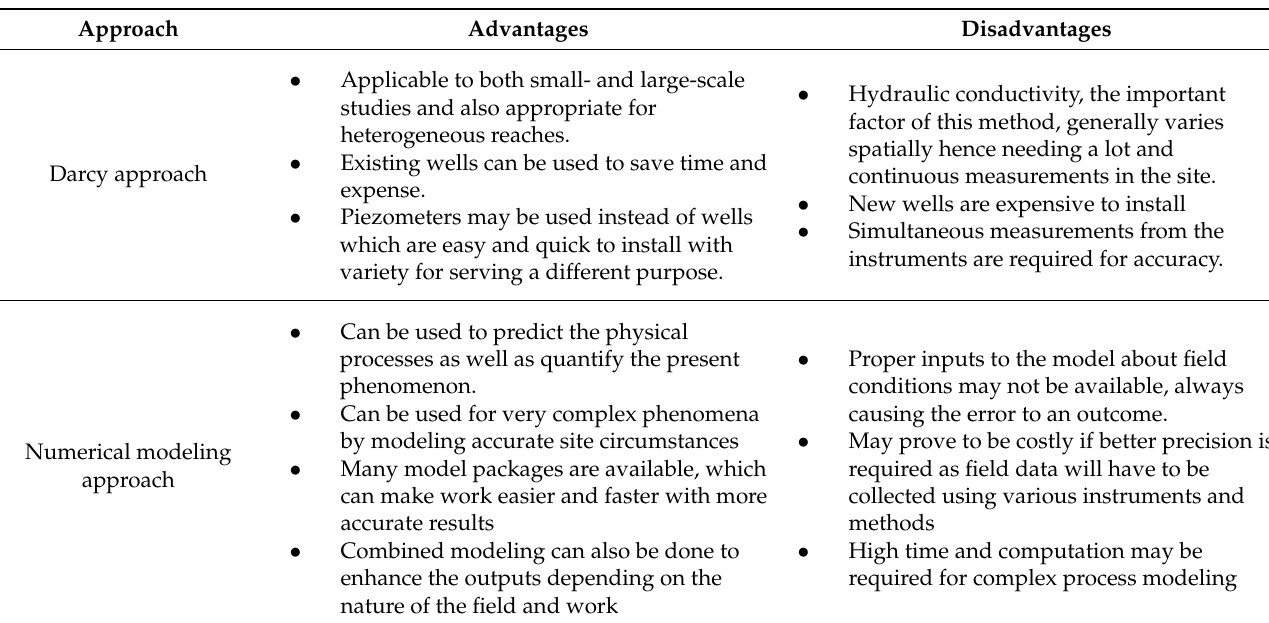
Table 3. Pros and cons of different approaches of GW–SW